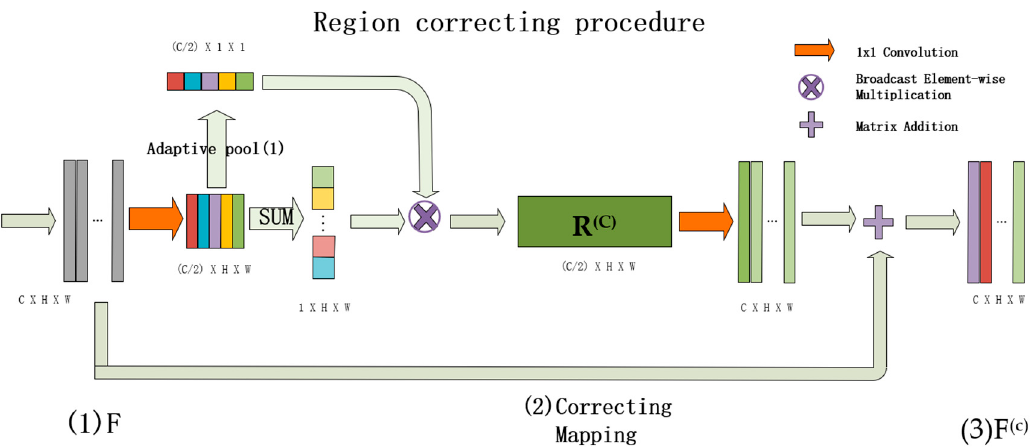
Figure 3. Detailed design drawing of the area correction procedure. Where, adaptive pool(1) represents the adaptive pooling operation of size 1. SUM represents the sum operation in channel dimension.